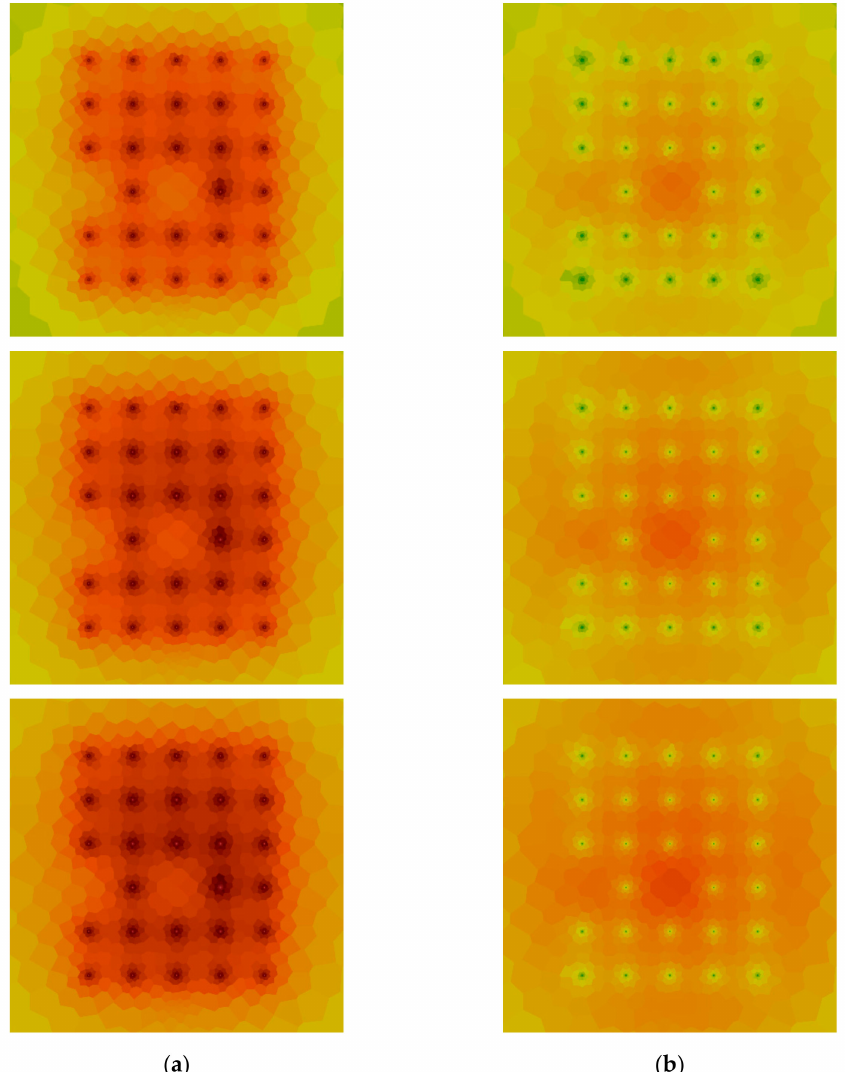
Figure 10. Temperature distribution around the BHE field at the depth of 50 m in 2018, 2030, 2040, and 2050 in order from the top: ( a ) after the cooling season and ( b ) after the heating